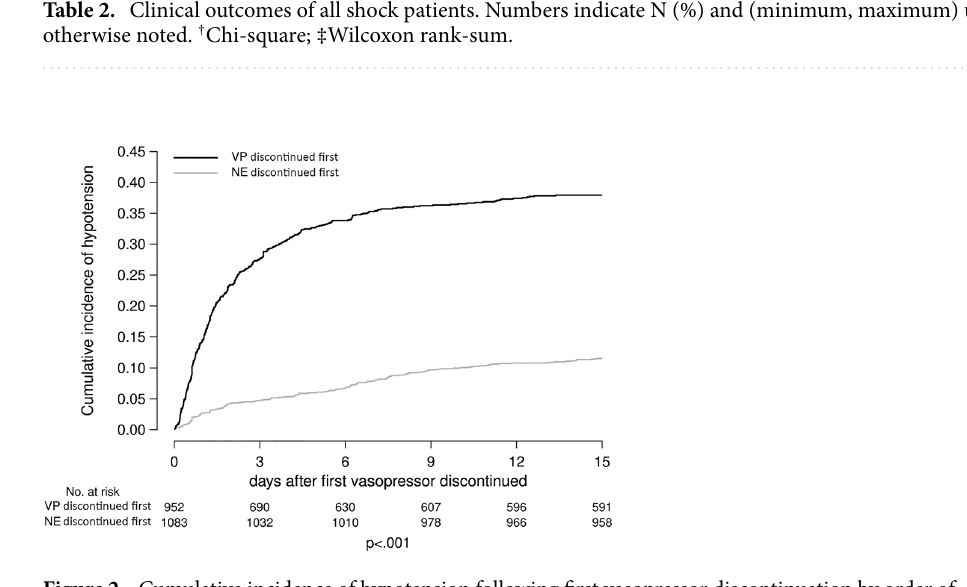
Figure 2. Cumulative incidence of hypotension following first vasopressor discontinuation by order of vasopressor